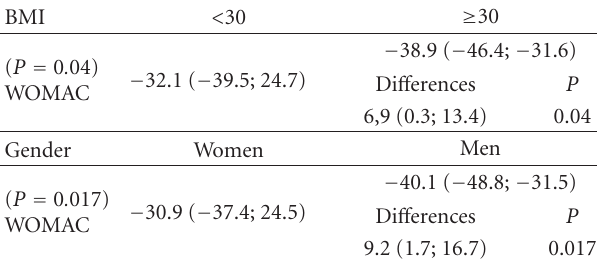
Table 3: Changes in WOMAC score adjusted for preoperative status and patient age for each of the factors studied. Results are expressed as mean and 95% confidence interval. Age was not statistically significant in the fitted model ( P = 0 . 097). The initial WOMAC score was statistically significant in the fitted model ( P < 0 . 001).